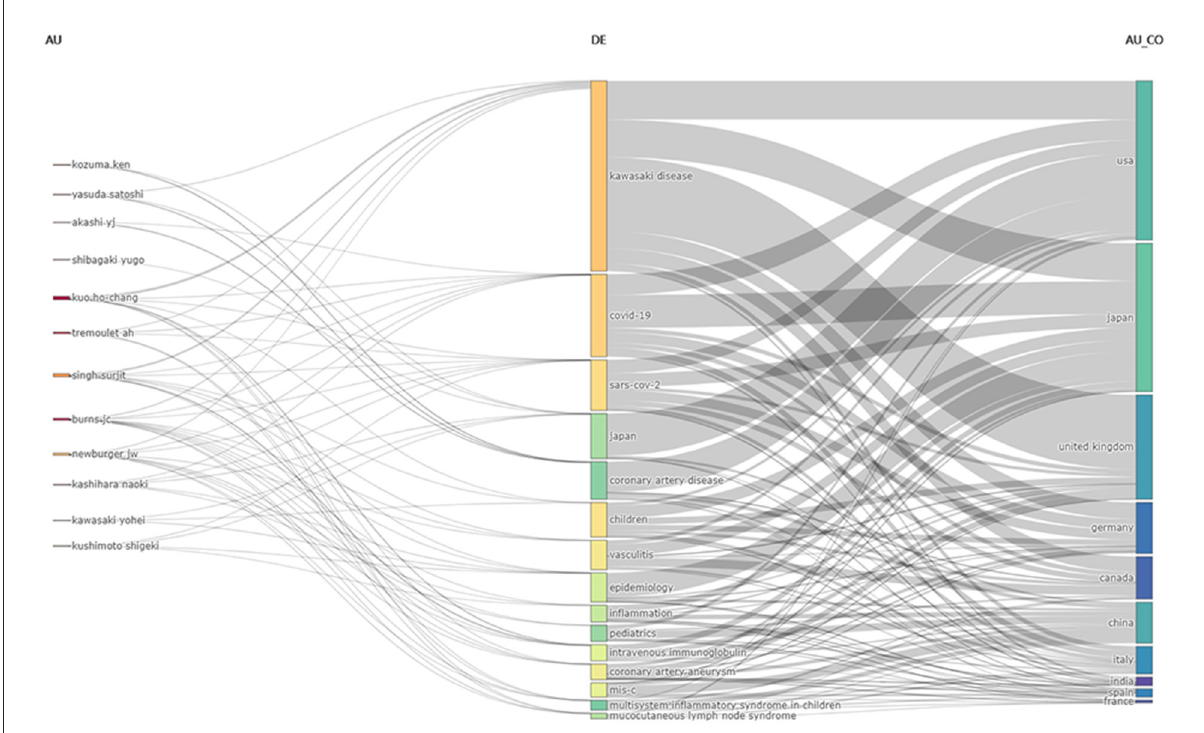
FIGURE8 Three field plots on KD research. The picture represents the authors who have made the greatest contribution to KD research in the past 5 years (2017–2021), the author keywords and the inflow and outflow of countries. AU, author; DE, author Keywords; AU_CO,